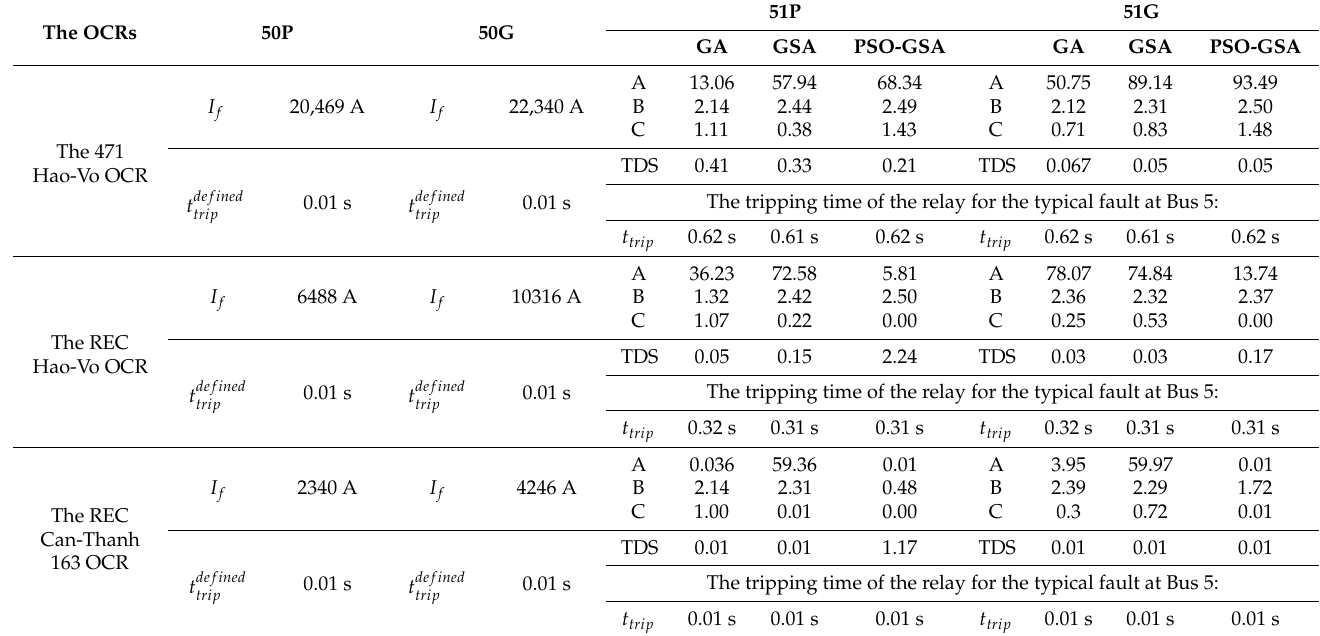
Table 4. Optimal protection coordination results of the OCRs in Scenario 1 and their tripping time when the fault is at Bus 5. The OCRs